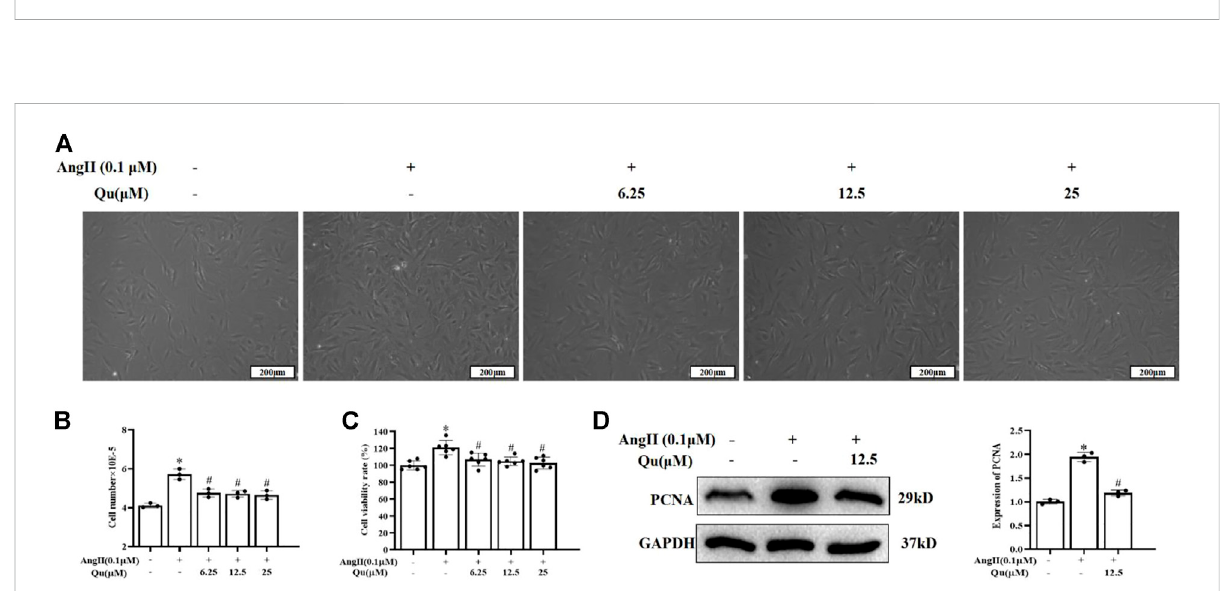
FIGURE 5 Quercetin ’ s in fl uences on Ang II-induced VSMCs. 0.1 µM of Ang II stimulated VSMCs were treated with quercetin (6.25, 12.5, and 25 µM) concentrations for 24 h, as shown in (A) , descriptive images of the cultured VSMCs. (B) Relative number of VSMCs was determined by cell counting. (C) VSMCs viabaility was analysed using CCK8 assay. Viability of untreated VSMCs was de fi ned as 100%. (D) Indicated PCNA protein expression usingwestern blotting. All values were denoted as mean ± SD; * p < 0.05 Ang II vs. control group, # p < 0.05 Ang II + quercetin vs. Ang II